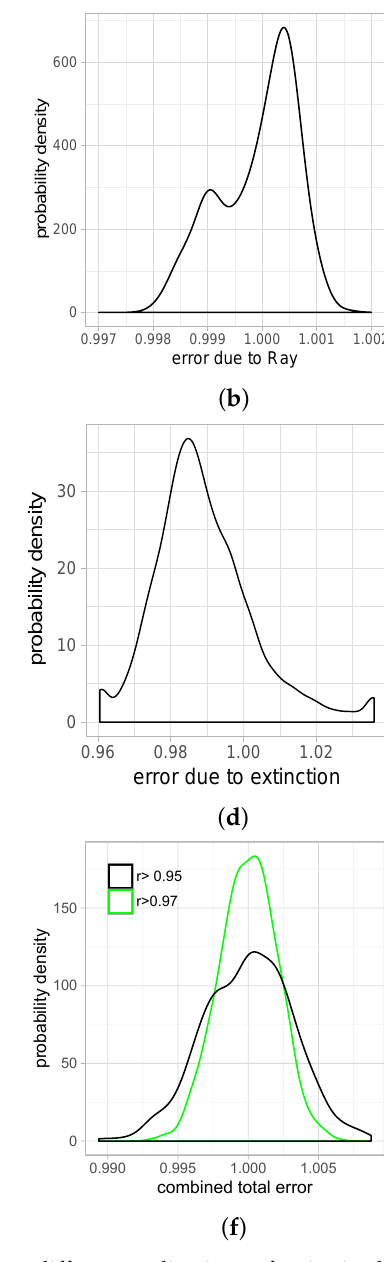
Figure 6. ( a )PDF of Pearson correlation coefficient how different realizations of noise in the lidar degrade a perfect r = 1 correlation; ( b )PDF of the error due to different Rayleigh atmospheres; ( c )median (dotted) and 95% percentile (dashed) of the error due to aerosol extinction as a function of altitude; ( d ) PDF of the aerosol induced error from AOD and Ångström exponent; ( e )PDF of Pearson correlation coefficient of the combined error due to noise and aerosol; and ( f ) accuracy for the determination of the lidar calibration